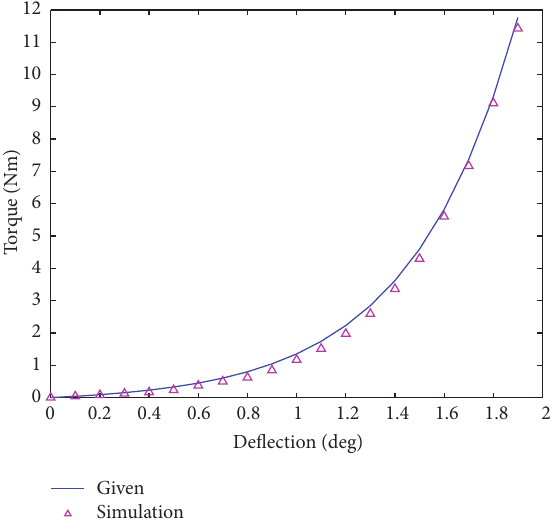
Figure 6: Uncompensated torque-deflection trajectory.